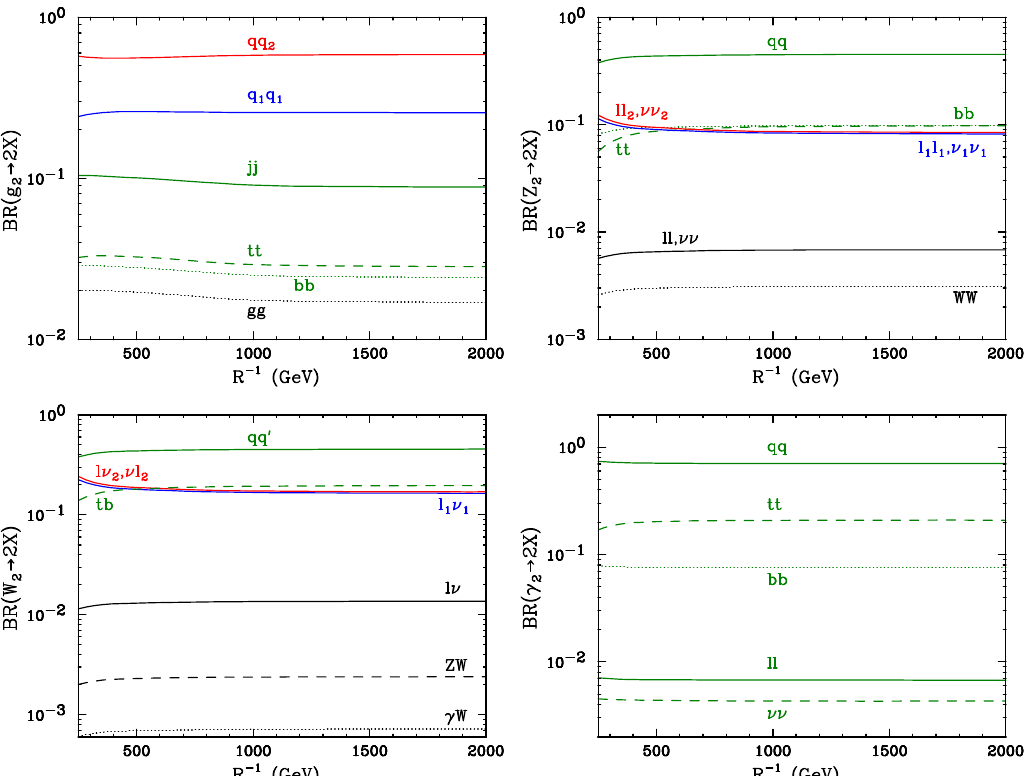
Figure 14 . Branching fractions of (cid:13) 2 , Z 2 , W (cid:6)